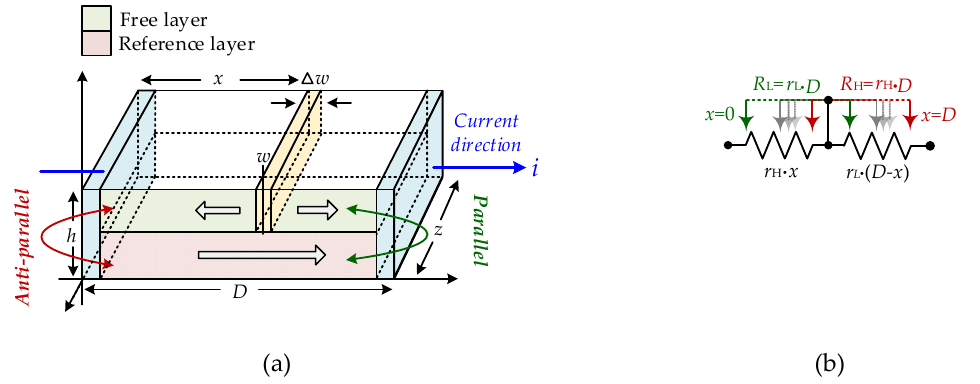
Figure 1. ( a ) 3D structure of a current in-plane spintronic memristor and ( b ) a simplified equivalent circuit.